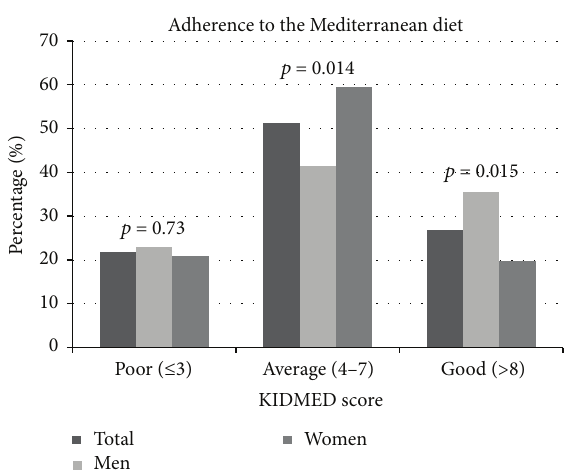
Figure 2: Distribution of KIDMED score categories in all and men and women